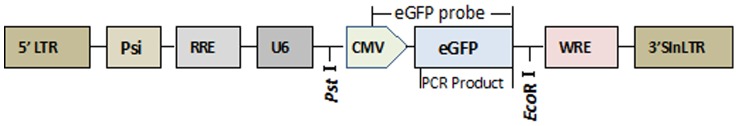
Diagram of the relevant regions of the pGCL-eGFP vector used to generate chimeric quail.LTR, long terminal repeat; Psi, packaging signal; RRE, rev responsive element;U6,U6 promoter; CMV, cytomegalovirus promoter; eGFP, enhanced green fluorescent protein gene; WRE, woodchuck hepatitis virus post-transcriptional regulatory element; SinLTR, self-inactivating LTR. The Southern blot probe and PCR product to detect the eGFP gene are indicated. PstI and EcoRI restriction enzymes were used for Southern blot analysis.